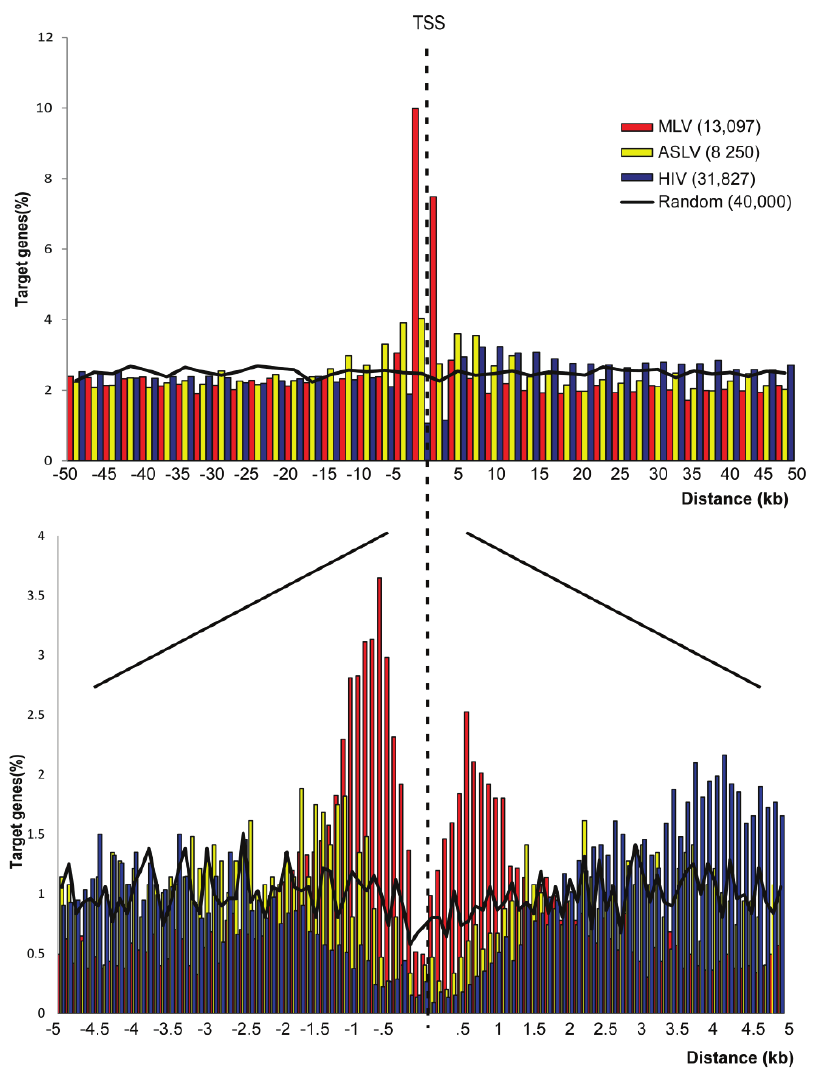
Figure 1. Genomic distribution of SIN-MLV, SIN-ASLV and SIN-HIV integrations in human HSPCs. The distribution of the distance of SIN-MLV (red bars), SIN-ASLV (yellow bars) and SIN-HIV (blue bars) integration sites from the TSS of targeted genes at 2500-bp ( a ) or 50-bp ( b ) resolution. The percentage of genes targeted at each position is plotted on the y-axis. The black line indicates the distribution of random control sites.